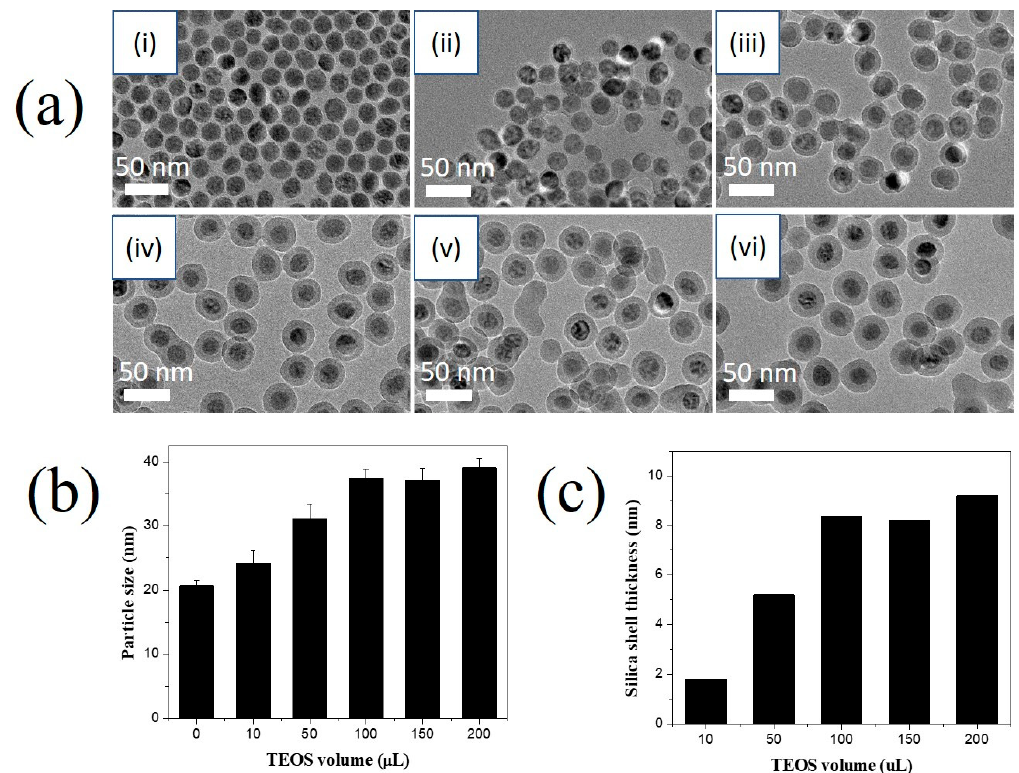
Figure 4. E ff ects of reverse microemulsion conditions on the silica coating of the magnetic nanoparticles. ( a ) TEM images ( b ) particle size and ( c ) silica shell thickness of MNP@SiO 2 synthesized at di ff erent volume of TEOS: (i) 0 µ L, (ii) 10 µ L, (iii) 50 µ L, (iv) 100 µ L, (v) 150 µ L, and (vi) 200 µ Lin the presence of 0.3 mL of Igepal ® CO-520, 5 mg of MNP, and 100 µ L of NH 4